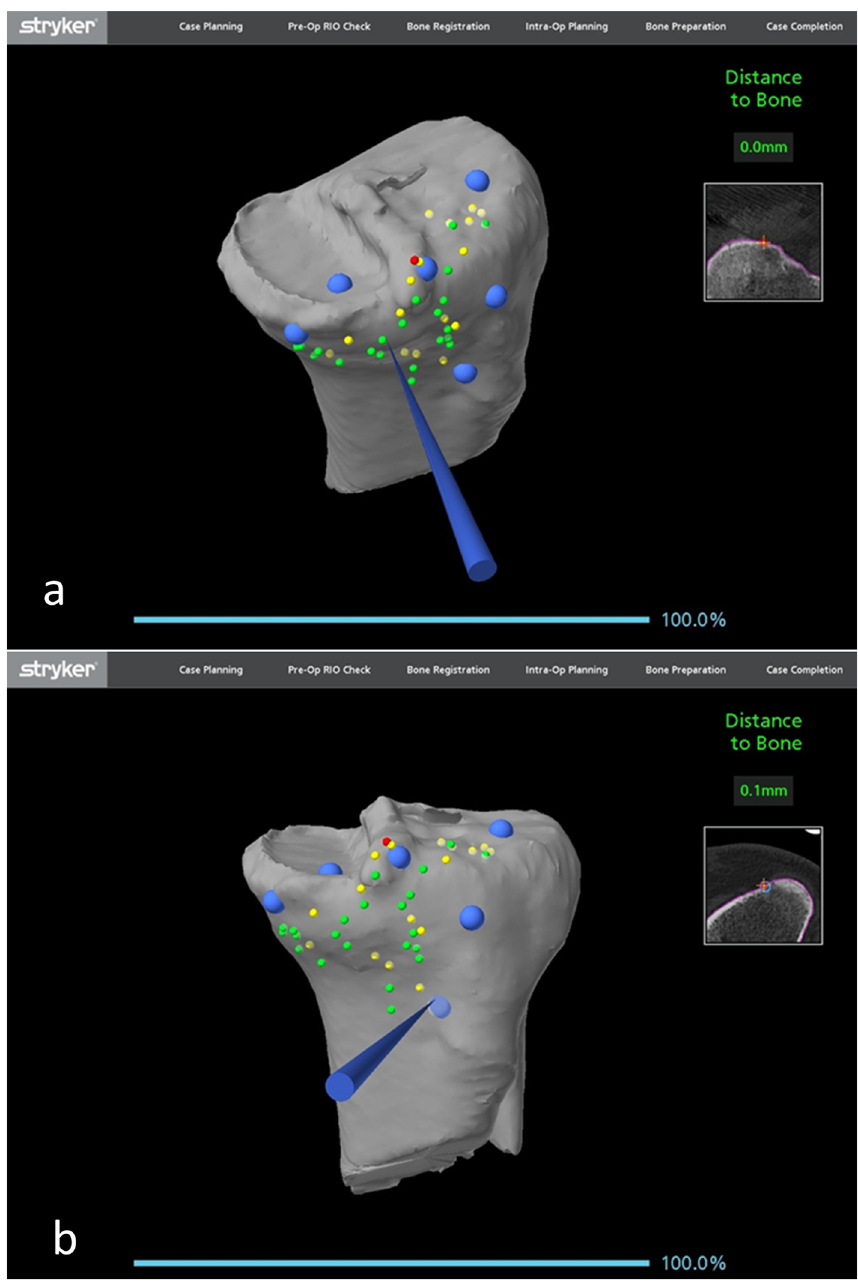
Fig. 14 Tibial bony landmark registration with a medial unicompartmental knee tibial tray in